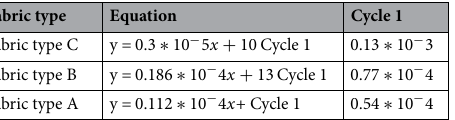
Table 1. The relationship between number of cycles and CV